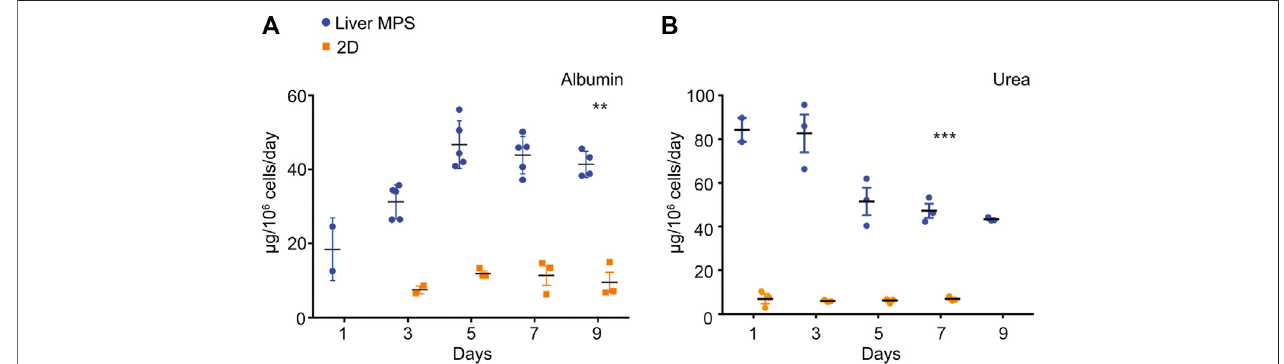
FIGURE3| SyntheticfunctionofhiPSC-Hepsinconventionalcellcultureand liverMPS. (A) Albuminsecretionintothemediameasured ontheindicateddaysafter seeding hiPSC-Heps into the liver MPS or replating them on conventional cell culture dishes (2D). Data are presented as the mean ± standard error of mean for fi ve (liver MPS) and three (2D) independent experiments. Unpaired Student ’ s t test with equal standard deviation, ** p < 0.05, *** p < 0.01. (B) Urea secretion into the media measured on the indicated days after seeding hiPSC-Heps into the liver MPS or replating them on conventional cell culture dishes. Data are presented as the mean ± standard error of mean for three independent experiments. Unpaired t -test with equal standard deviation, *** p <